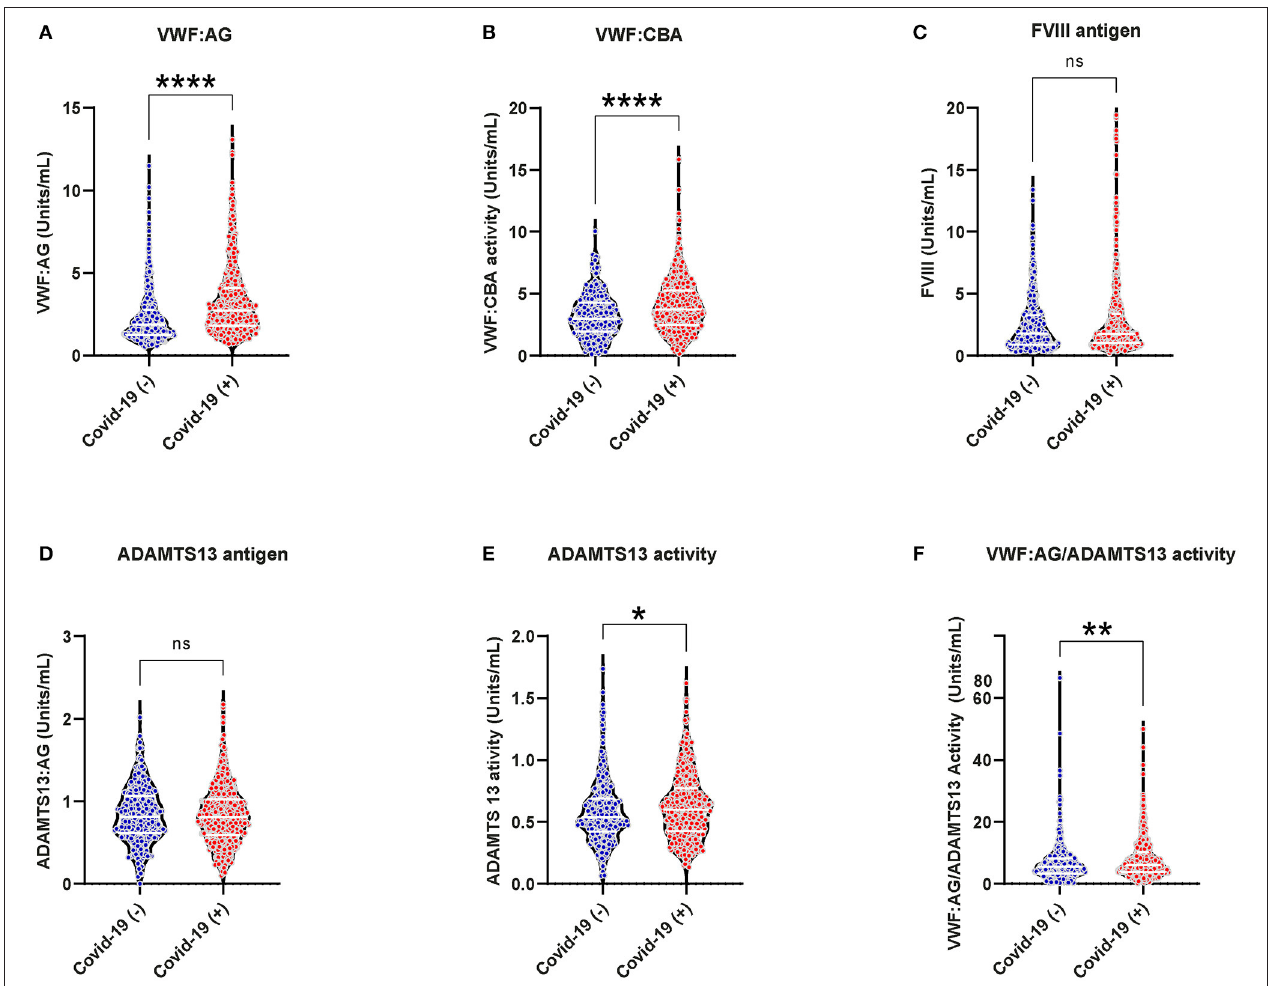
FIGURE 1 | VWF/ADAMTS13 axis changes and coagulation in acutely ill COVID-19 ( − ) and ( + ) patients: (A) VWF antigen, 1.868 (IQR, 1.257–2.770) ( − ), 2.736 (IQR, 1.822–4.060) ( + ), p < 0.0001; (B) VWF collagen binding activity ( 9) 2.989 (IQR, 1.958–4.252) ( − ), 3.745 (IQR, 2.506–5.262) ( + ), p < 0.0001; (C) FVIII antigen 1.79 (IQR, 0.898–3.283) ( − ), 1.769 (IQR, 1.031–3.366) ( + ), p = 0.4154; (D) ADAMTS13 antigen 0.806 (IQR, 0.592–1.023) ( − ), 0.813 (IQR, 0.614–1.069) ( + ), p = 0.539; (E) ADAMTS13 activity 0.540 (IQR, 0.420–0.689) ( − ), 0.597 (IQR, 0.427–0.767) ( + ), p = 0.027; (F) VWF:AG/ADAMTS13 activity 5.567 (IQR, 3.352–8.245) ( − ), 6.051 (IQR, 3.824–10.17) ( + ), p < 0.0044. Datapoints indicate individual measurements, and p -values are from the Mann-Whitney analysis for comparison within groups. Values are presented as median and interquartile range (IQR, 25th − 75th percentile) for continuous variables. ns, P > 0.05; * P ≤ 0.05; ** P ≤ 0.01; *** P ≤ 0.001; **** P ≤ 0.0001.